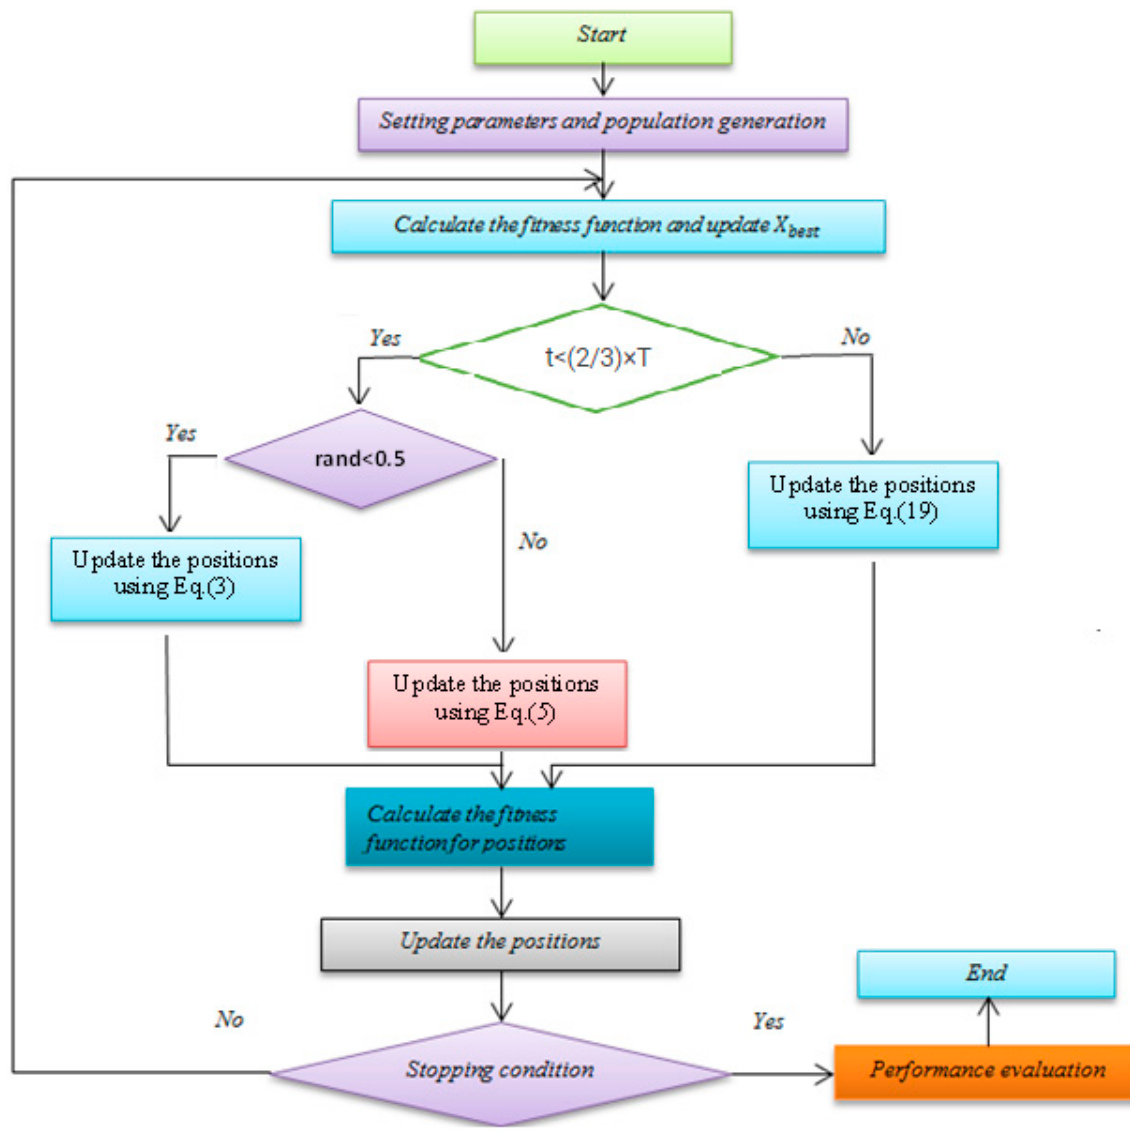
Figure 2. Diagram of the proposed AO_AVOA.